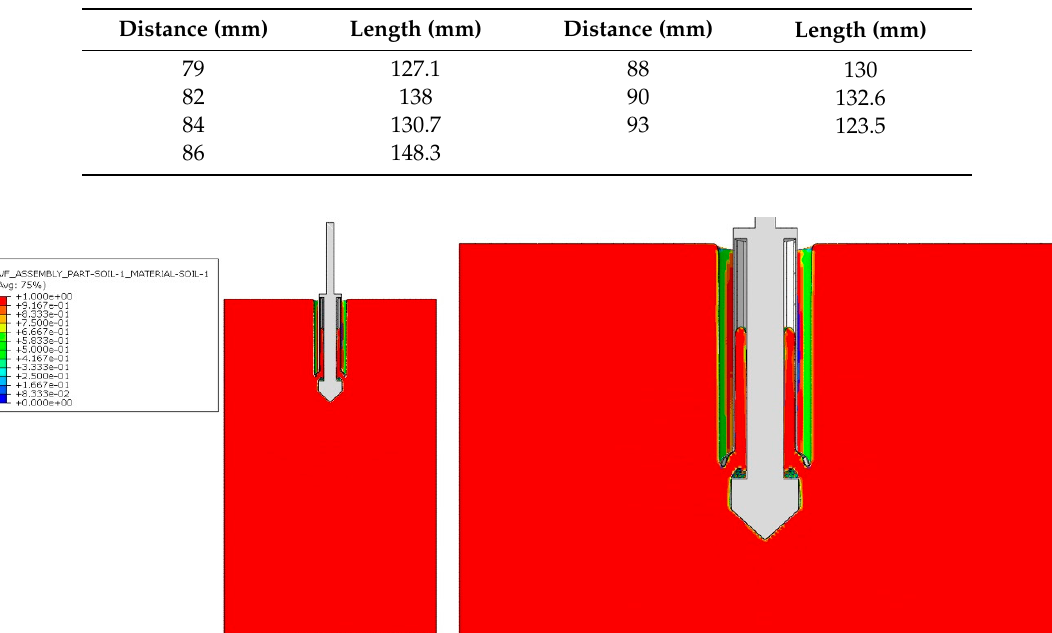
Figure 8. The simulation result at sampling.